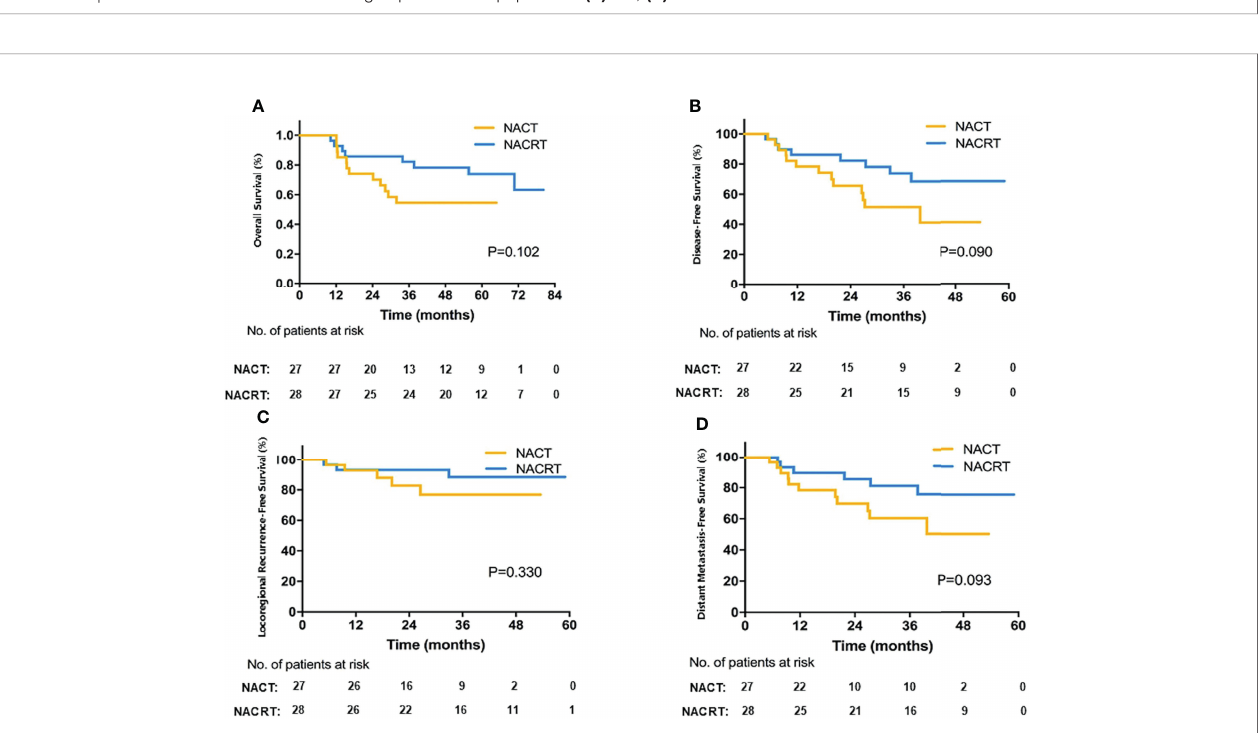
FIGURE 3 | Survival of patients in the NACT and NACRT groups with R0 resection. (A) OS; (B) DFS; (C) LRFS; (D)